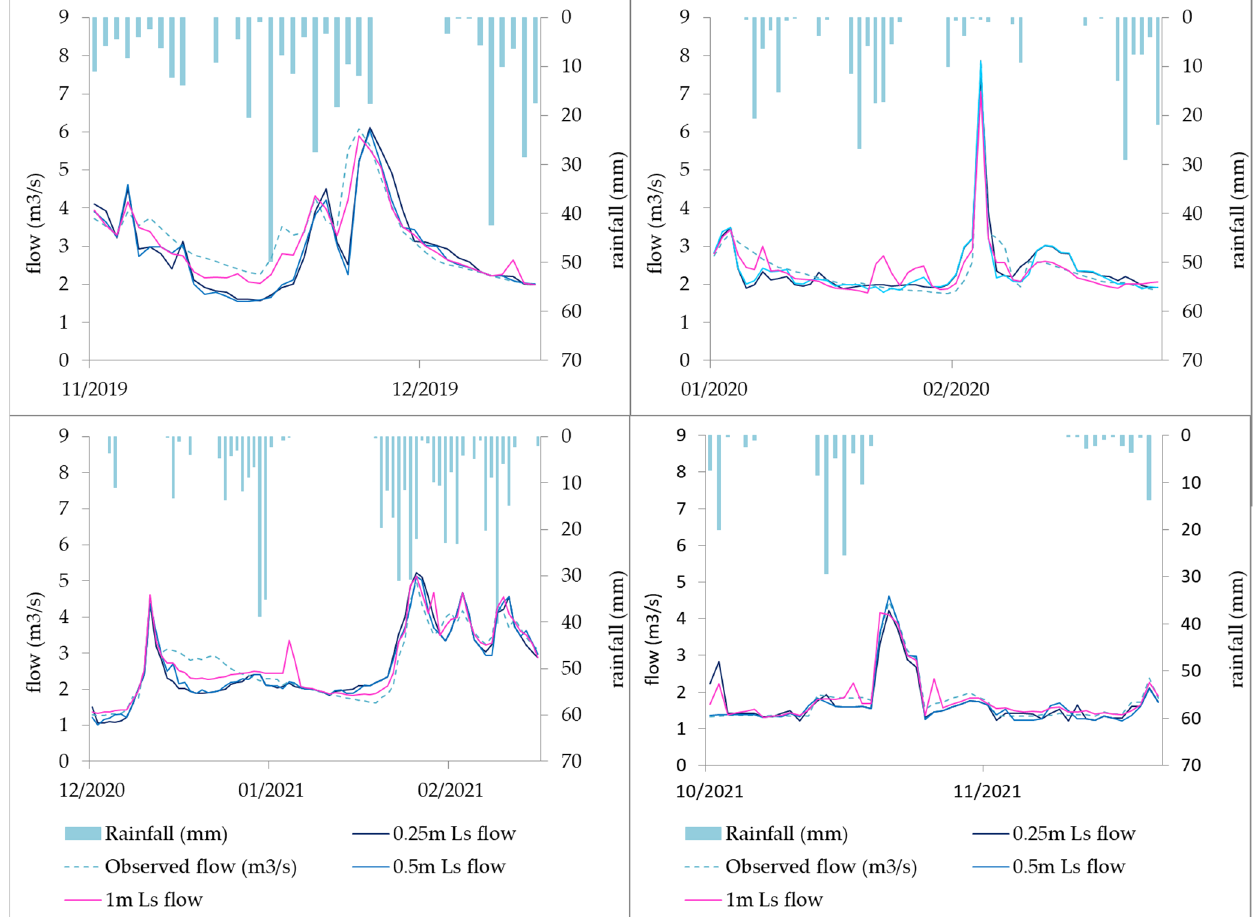
Figure 6. Observed and simulated streamflow for the terrace’s scenarios (0.25 m, 0.50 m, and 1 m Ls DEMs), from November 2019 to November 2021.